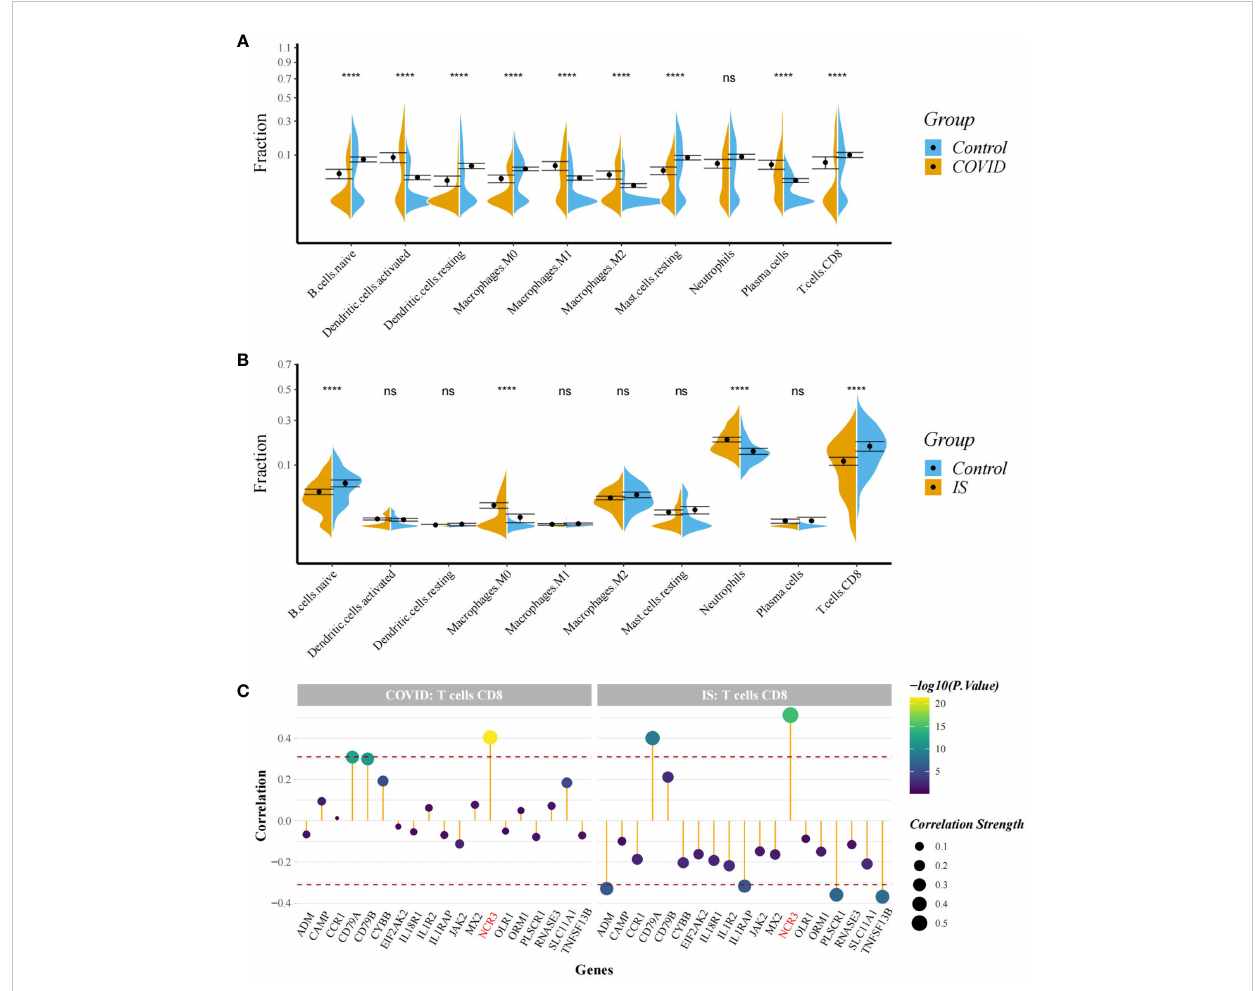
FIGURE 7 (A, B) Comparison of proportion of immune cells between COVID-19/IS and controls with t-test. Analyses were performed using CIBERSORT. ****:P < 0.0001 (C) Spearman Correlation Analysis between the gene expression of common IDEGs and CD8 + T cell proportion. The red dashed lines represent +0.3 and -0.3. "ns" means P value > 0.05, representing no difference between the case and